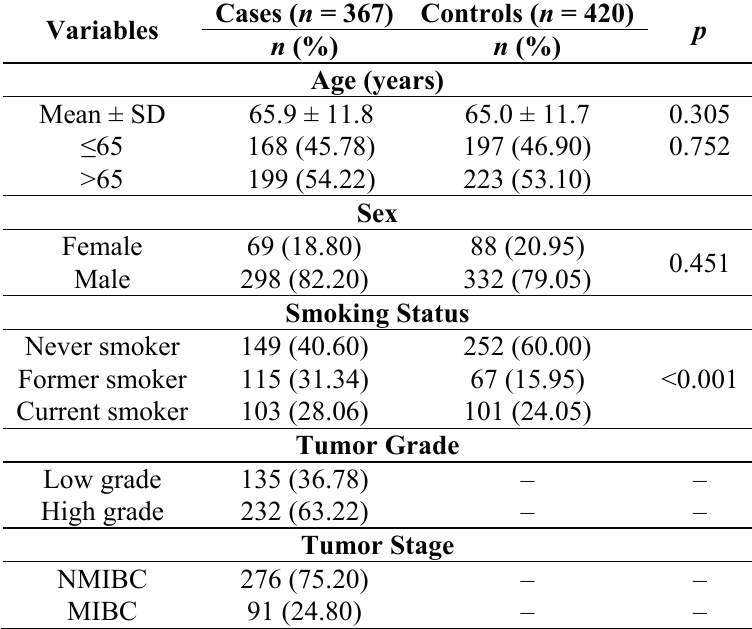
Table 1. Characteristics of the study